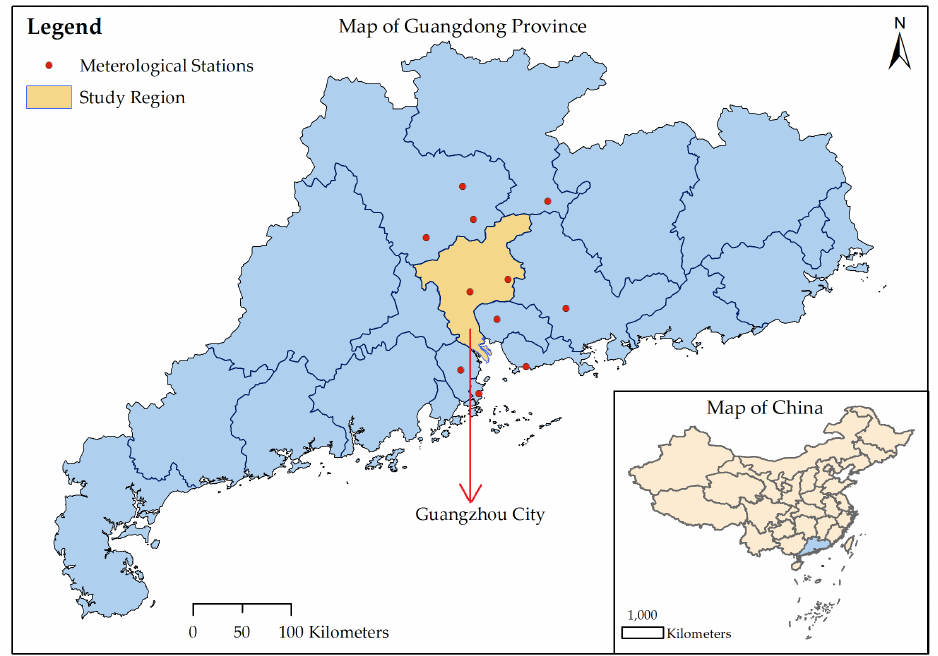
Figure 1. Geographic locations of Guangdong Province, the city of Guangzhou and the meteorological stations used to interpolate the climate data for